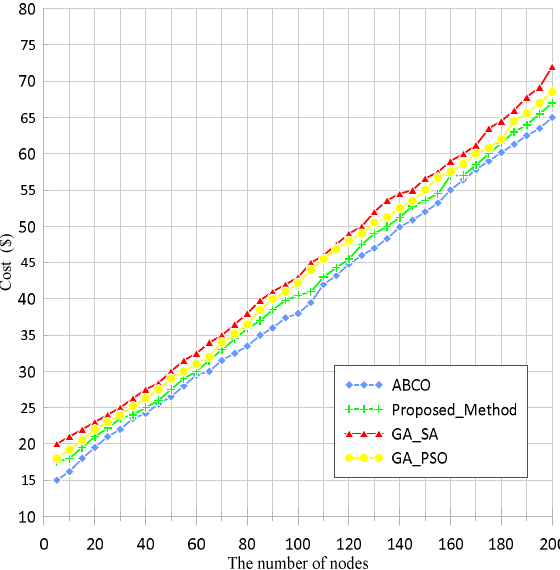
Figure 8. The gas injection of the proposed method and three evolutionary algorithms.